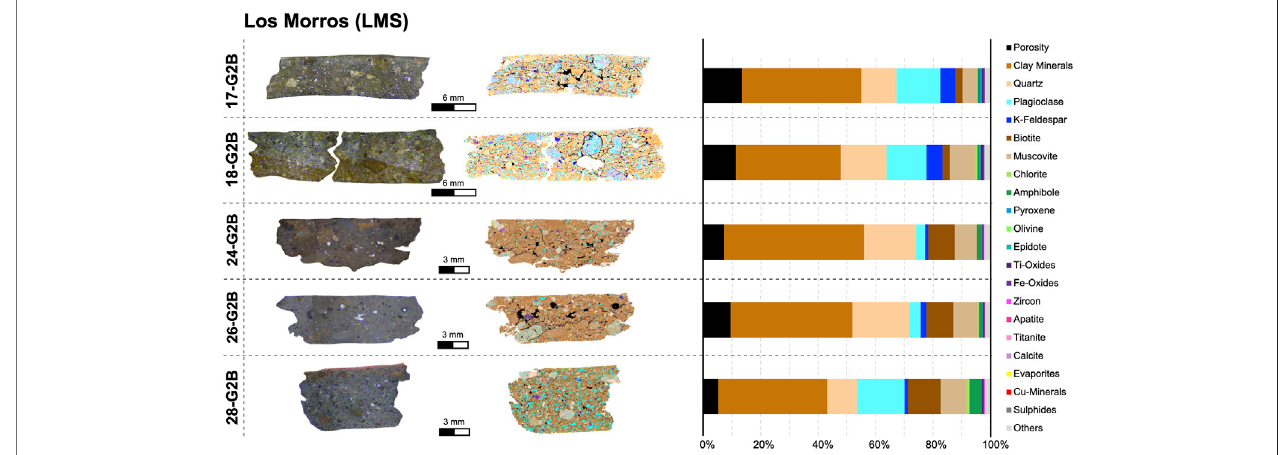
FIGURE 6 | Fresh pastes (left), mineralogical maps (middle), and modal mineralogy (right) of the studied Los Morros (LMS) ceramic samples.